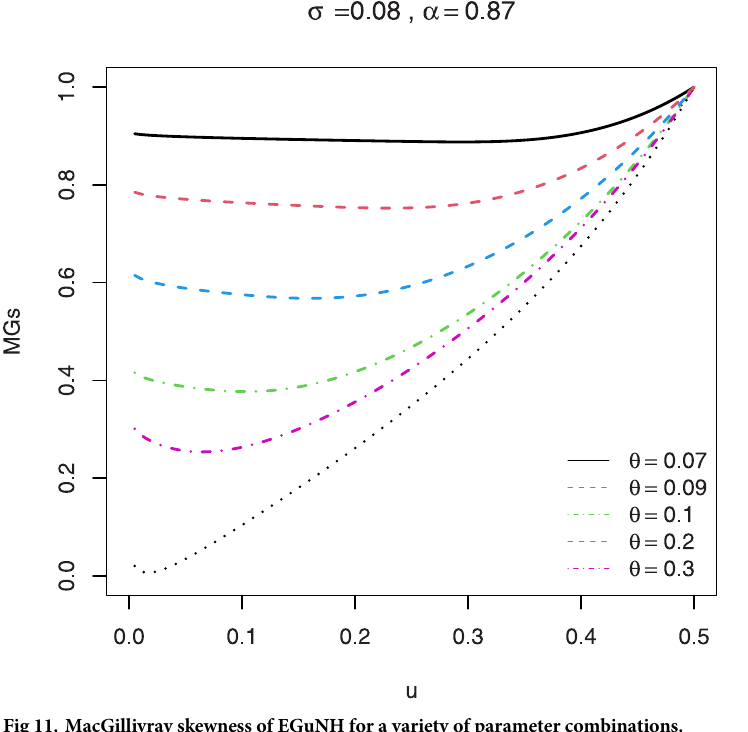
Fig 11. MacGillivray skewness of EGuNH for a variety of parameter combinations.